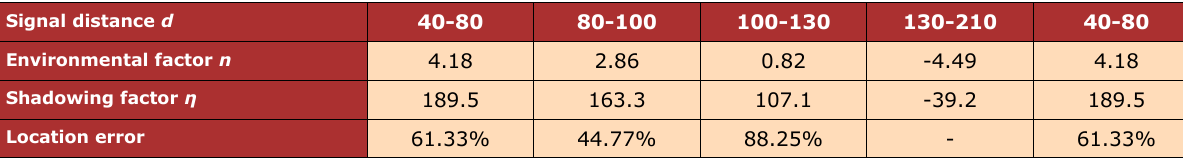
Table 3. Fitting model in long